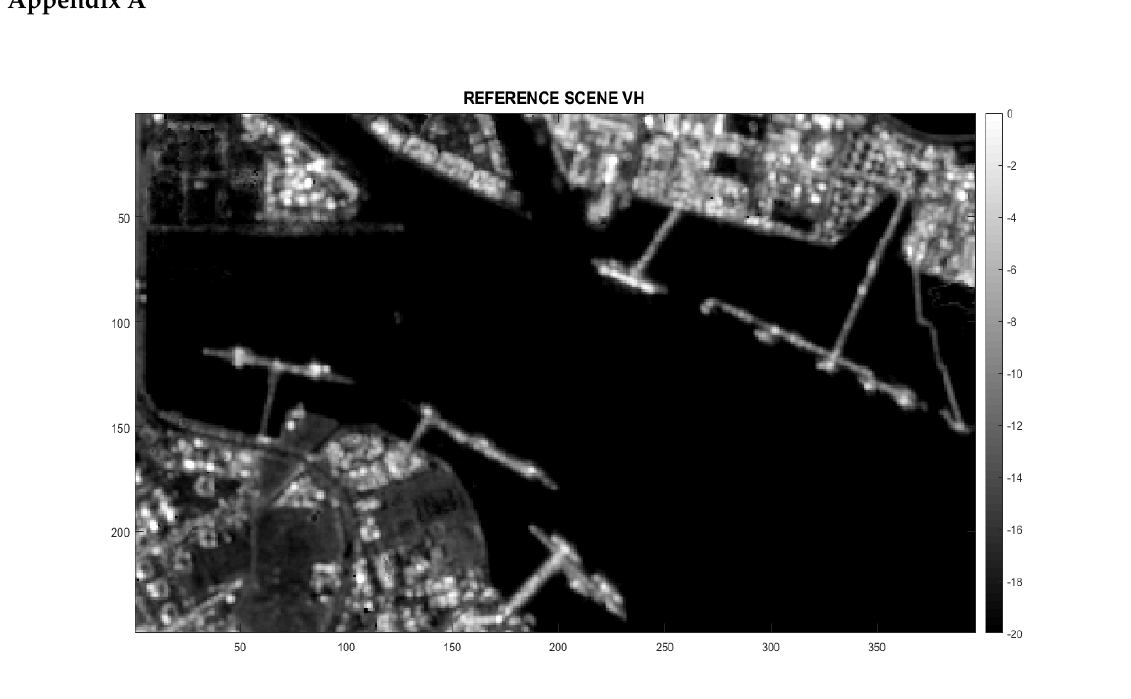
Figure A1. Reference Scene Projected on Google